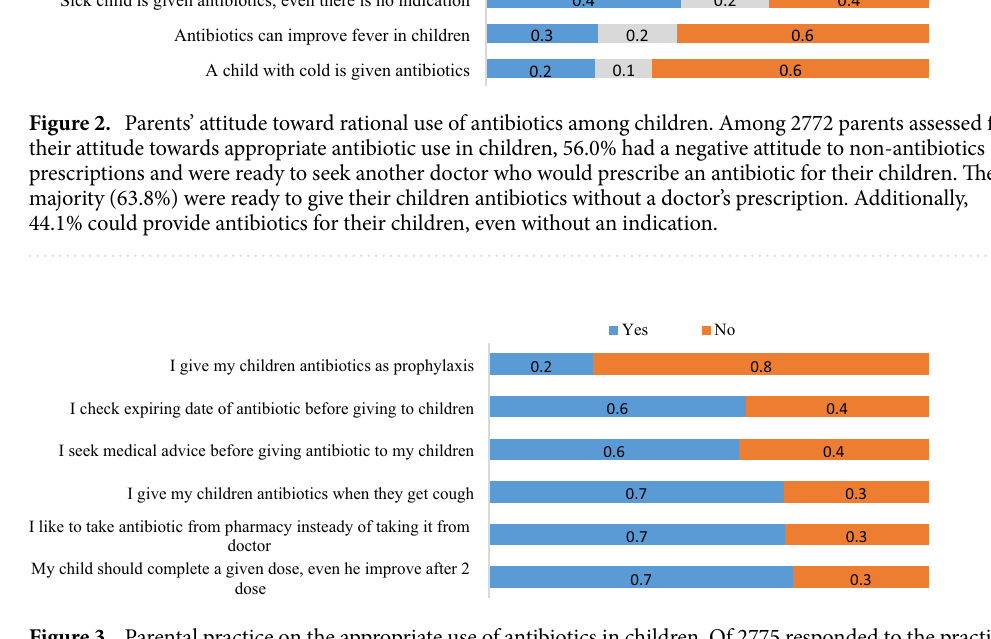
Figure 3. Parental practice on the appropriate use of antibiotics in children. Of 2775 responded to the practice questions, 67.0% like to take medicine from pharmacies than doctors. Some parents (30.3%) were ready to stop giving antibiotics to their children when there were improvements. About 33% of parents gave antibiotics to their children when they had a cough. Regarding the expiry date, 41.7% reported that they don’t check the expiring dates of antibiotics before giving to their children.